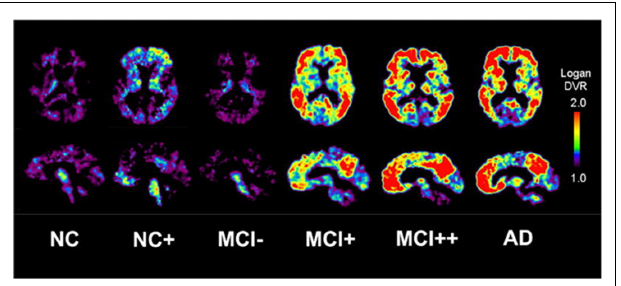
FIGURE 3 |Transaxial and sagittal planes of 11 C-PIB PET scans in a normal control (NC), a 11 C-PIB-positive NC (NC + ), 11 C-PIB-negative MCI subject (MCI − ), a 11 C-PIB-positive MCI subject (MCI + ), a highly 11 C-PIB-positive MCI subject (MCI ++ ), and a 11 C-PIB-positiveAD patient (AD). Reprinted from Mathis et al.